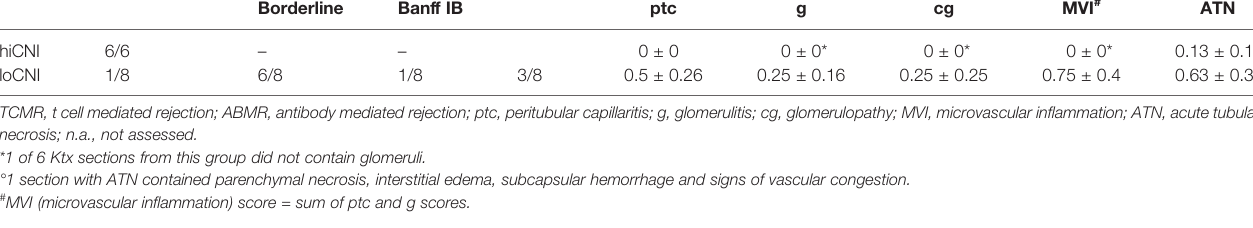
TABLE 2 | Histopathological evaluation of allograft sections in analogy to Banff classi fi cation 2017. Group no